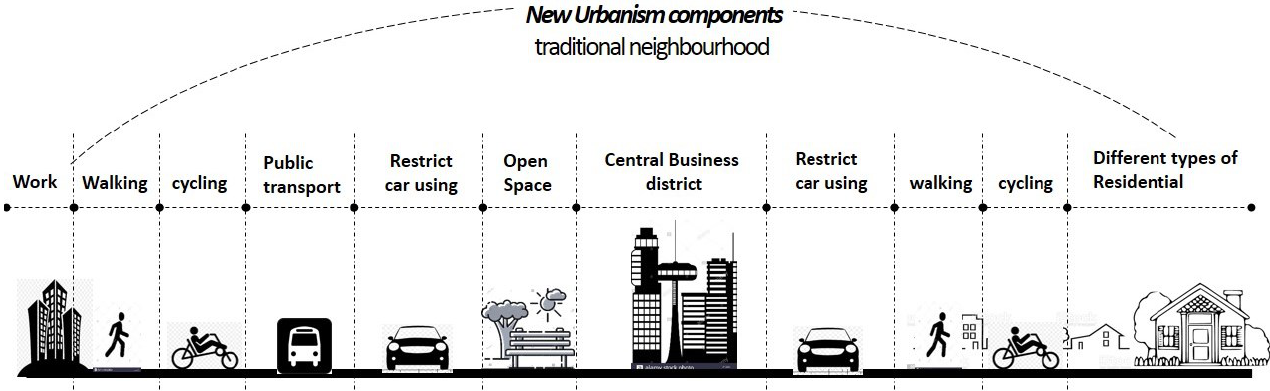
Figure 2. Daily trips in new urbanism – source the